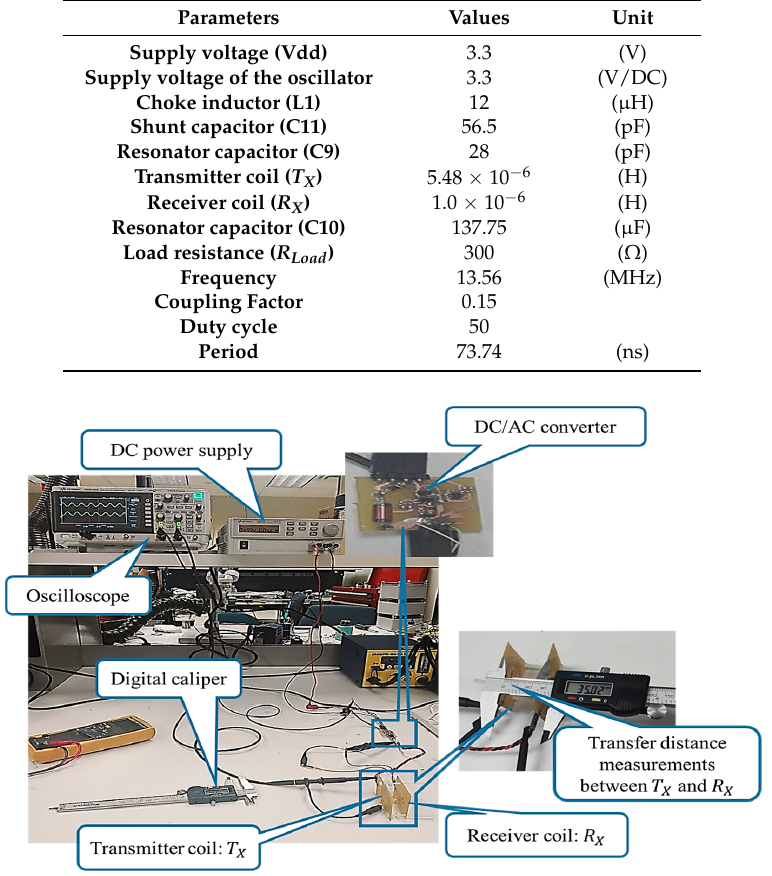
Energies 2019 , 12 , x FOR PEER REVIEW Figure 15. Experimental setup to measure the transferred power as a function of the transfer distance.